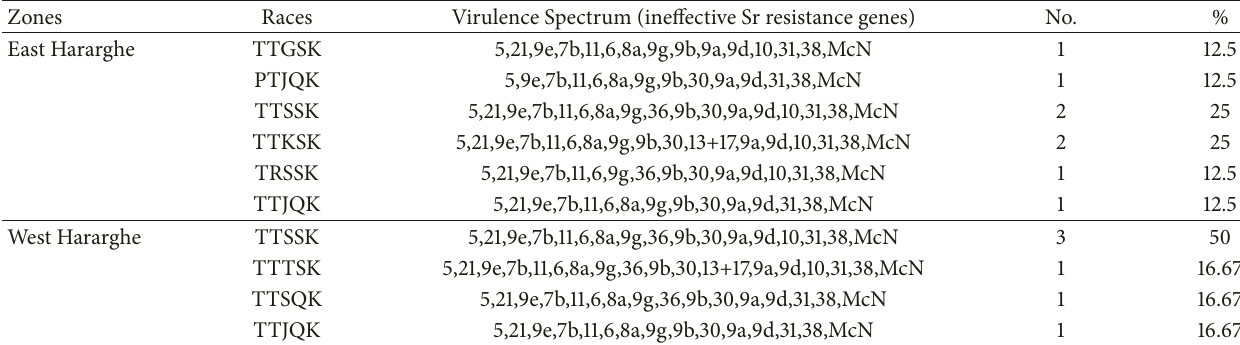
Table 4: The number of ineffective Sr-genes and frequency of Puccinia graminis f. sp. tritici races collected from East and West Hararghe zones in 2016 main cropping